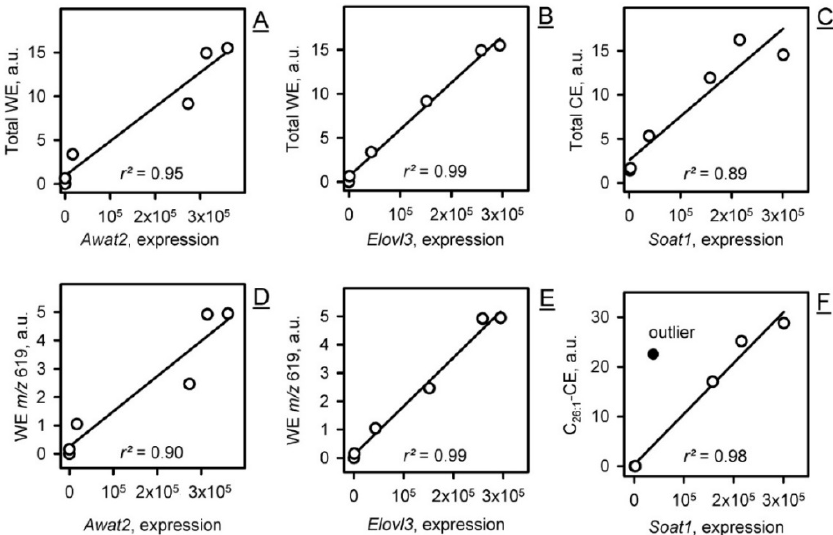
Figure 10. The levels of specific lipid classes and individual lipids in Meibomian lipidomes of P0 to AD mice positively correlated with the levels of expression of related genes. ( A ) Total WEs vs. Awat2 . ( B ) Total WEs vs. Elovl3 . ( C ) Total CEs vs. Soat1 . ( D ) An individual WE with m/z 619.6393 vs. Awat2 . ( E ) The same WE vs. Elovl3 . ( F ) An individual C 28:1 -CE vs. Soat1 . An outlier is shown as a black dot.